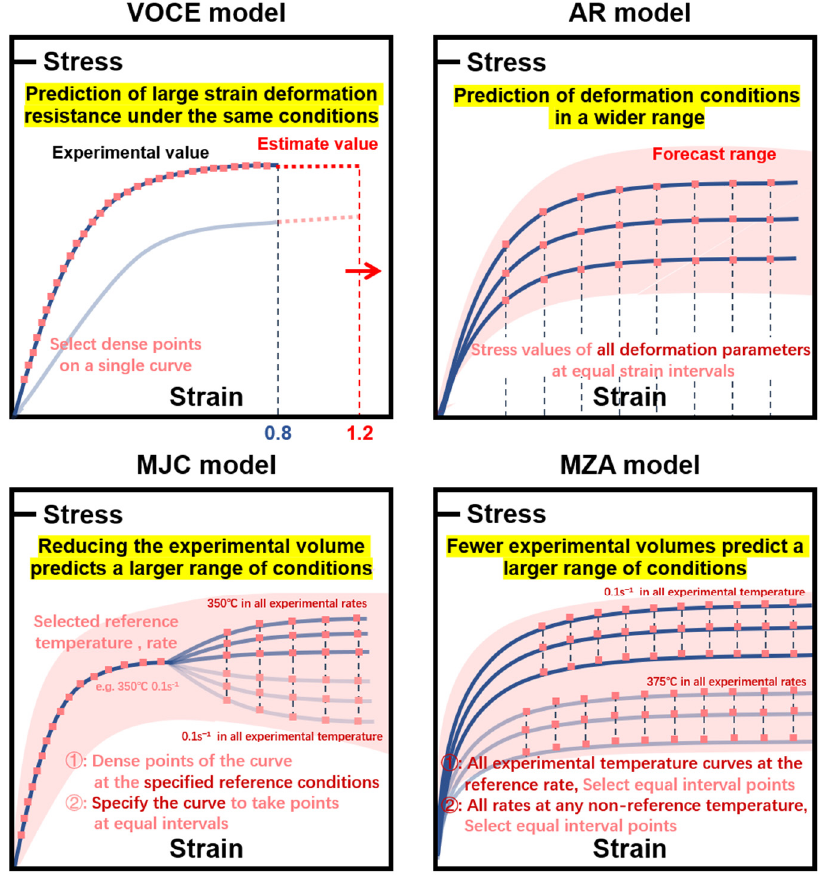
Figure 20. Four types of model data characteristics and model characteristics.